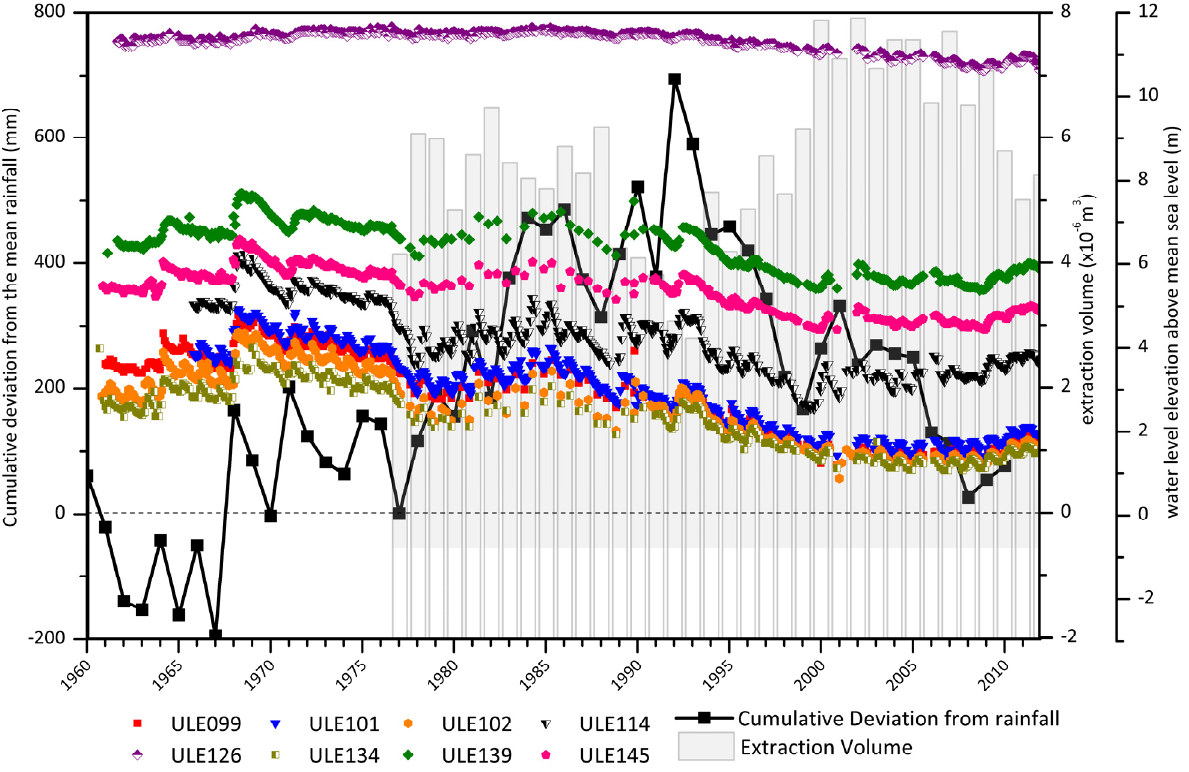
Figure 10. Water level trends in long-term monitoring wells, cumulative deviation from mean rainfall and groundwater extraction in Uley South